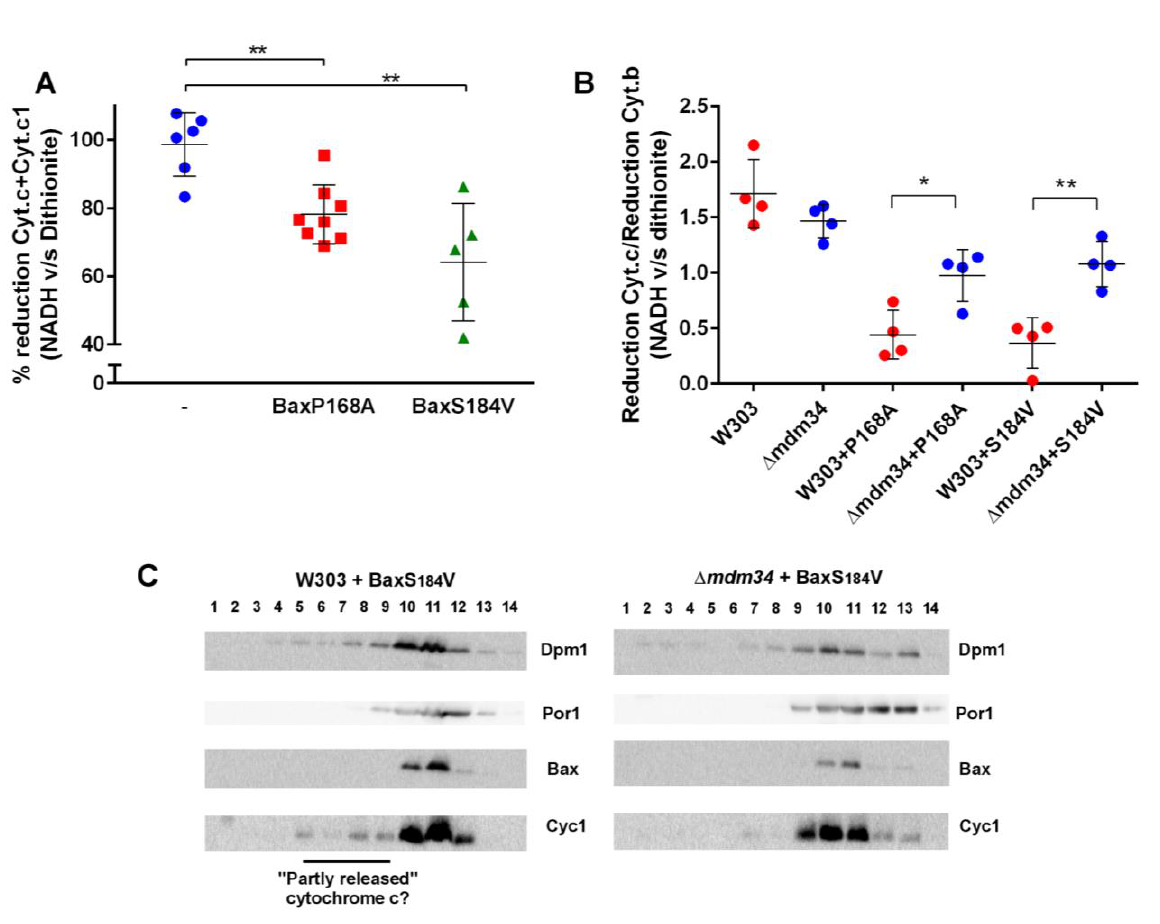
FIGURE 4: An incompletely released, MAMs-associated, pool of cytochrome c is decreased in Δ mdm34 cells. (A) The fraction of NADH- reducible cytochrome c was measured by measuring reduction after adding 1 mM NADH, followed by measuring the reduction after add- ing dithionite on the same sample. Typically, two redox spectra with NADH and two redox spectra with dithionite were acquired sequen- tially, to ensure that redox ratios did not change during the time of the experiment. Each point is a different mitochondria preparation (**: significantly different p<0.01). (B) The ratio (reduction by NADH/reduction by dithionite) was measured for cytochrome c and for cyto- chrome b. The graph shows the ratio (% reduction cytochrome c) / (% reduction of cytochrome b). The values were corrected to remove the contribution of cytochrome c1, considering that the molecular ratio cyt.b/cyt.c1 is 2 and that the reduction of cytochrome c1 was pro- portionnal to that of cytochrome b (as they belong to the same respiratory complex). Each point is a different mitochondria preparation. (*: p<0.05; **: p<0.01). (C) Mitochondria were fractionated on a sucrose density gradient. A small pool of cytochrome c was found at a lower density than that of the main fraction, and may represent partly released cytochrome c, not reducible by NADH in experiments (A) and (B). The figure is representative of 3 independent OPEN ACCESS | www.microbialcell.com 262 Microbial Cell | MAY 2019 | Vol. 6 No. 5